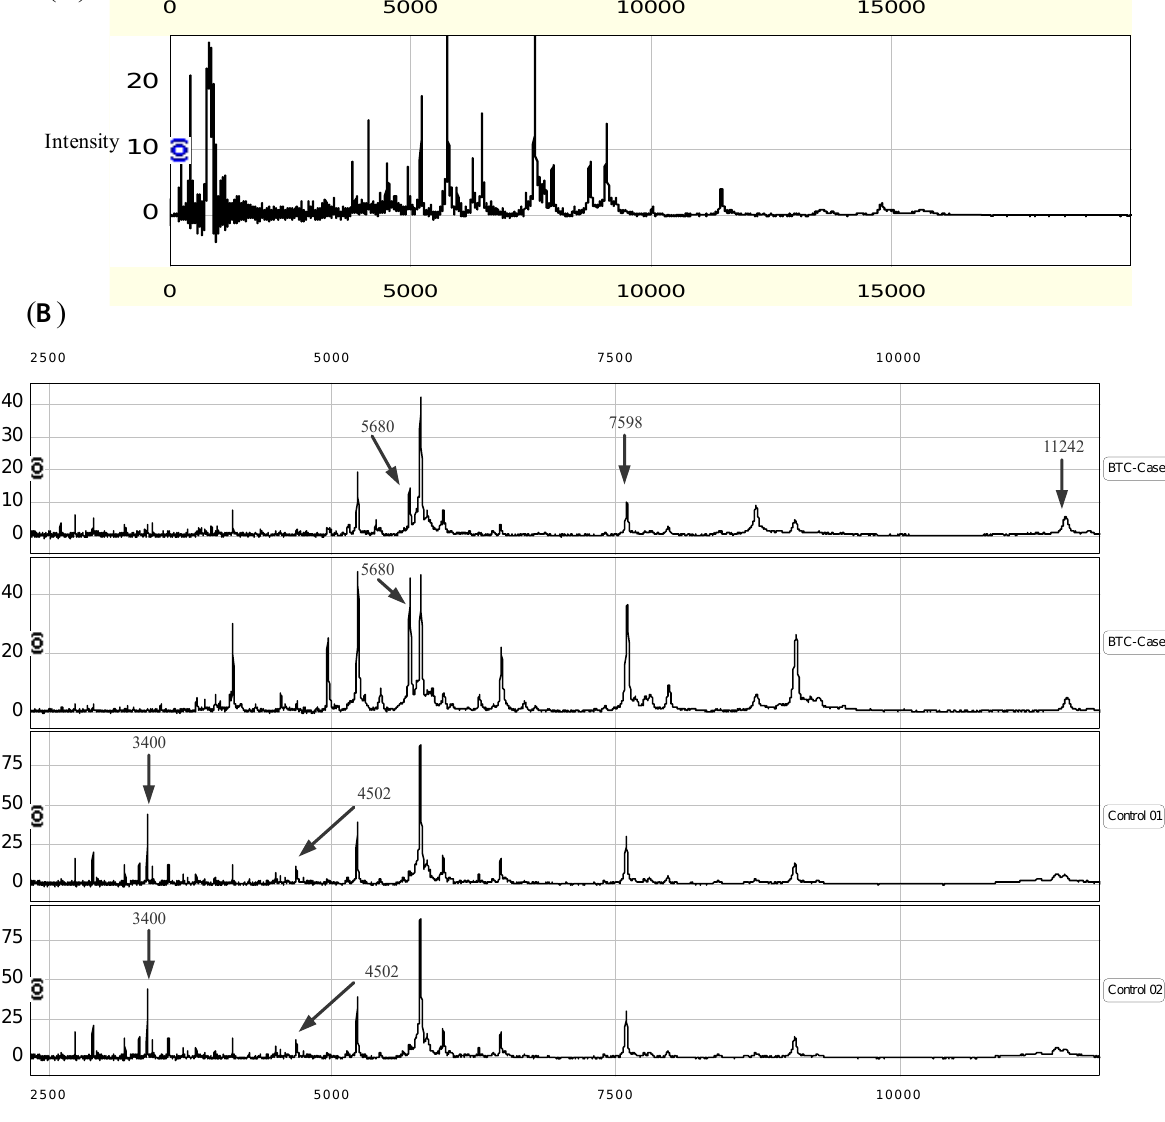
Figure 1. ( A ). Representative protein mass spectra of the sera sample processed on an IMAC30 ProteinChip surface, showing the proteins with masses between 0 and 20,000 m/z . ( B ). Detection of five proteins in the mass pattern of serum. Mass spectra of sera samples from two different BTCs (BTC-Case 01 and 02) and two non-cancer controls (Control 01 and 02) were generated on an IMAC30 ProteinChip array. The signal intensity at five proteins was significantly different between the BTCs and the normal specimens. The average molecular masses of the proteins identified as down-regulated in case specimens were m/z 3,400, 4,502 and 7,598 Da and as up-regulated were m/z 5,680 and 11,242 Da. 0 5000